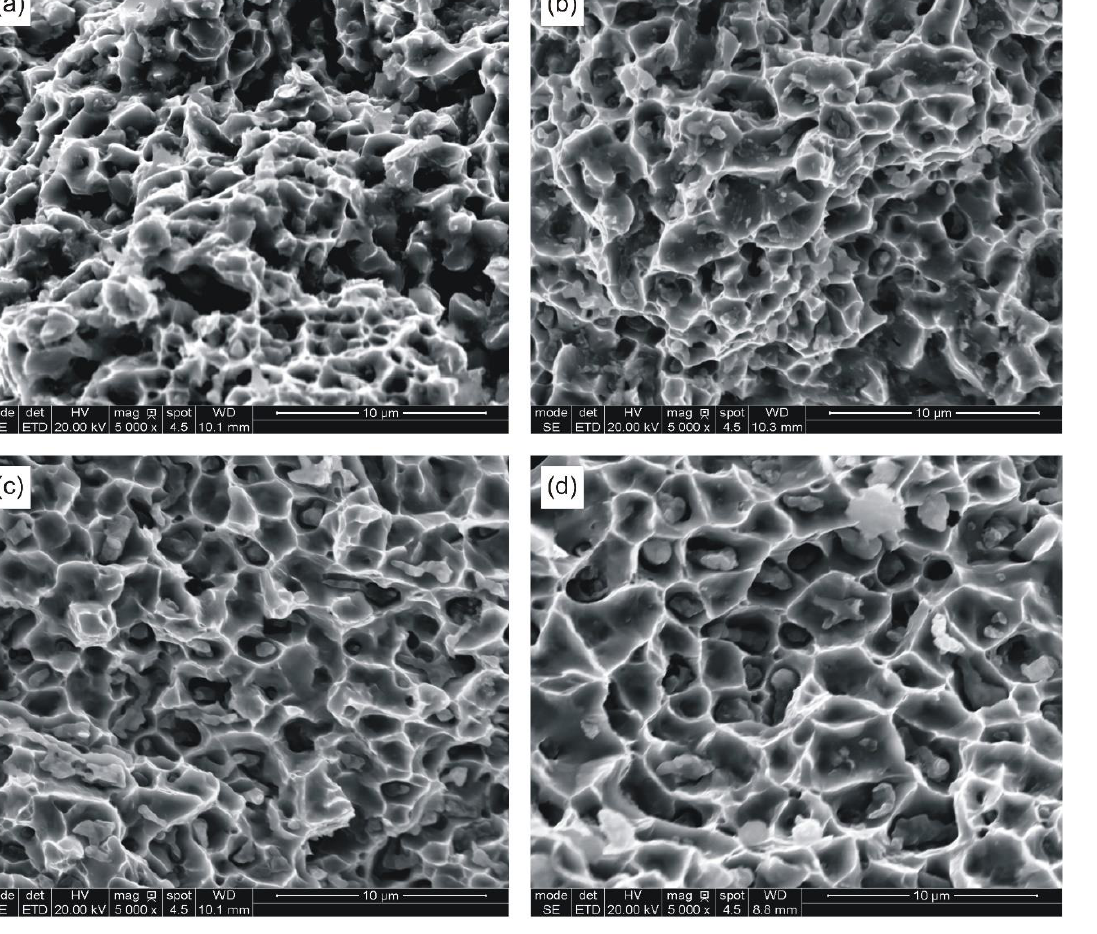
Figure 4. SEM fractographs of samples sintered at: ( a ) 850 °C; ( b ) 874 °C; ( c ) 898 °C; and ( d ) 924